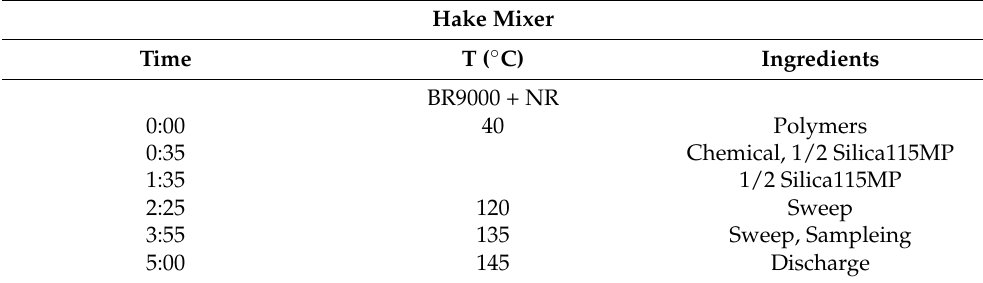
Table 3. Mixing process of mixed rubber.